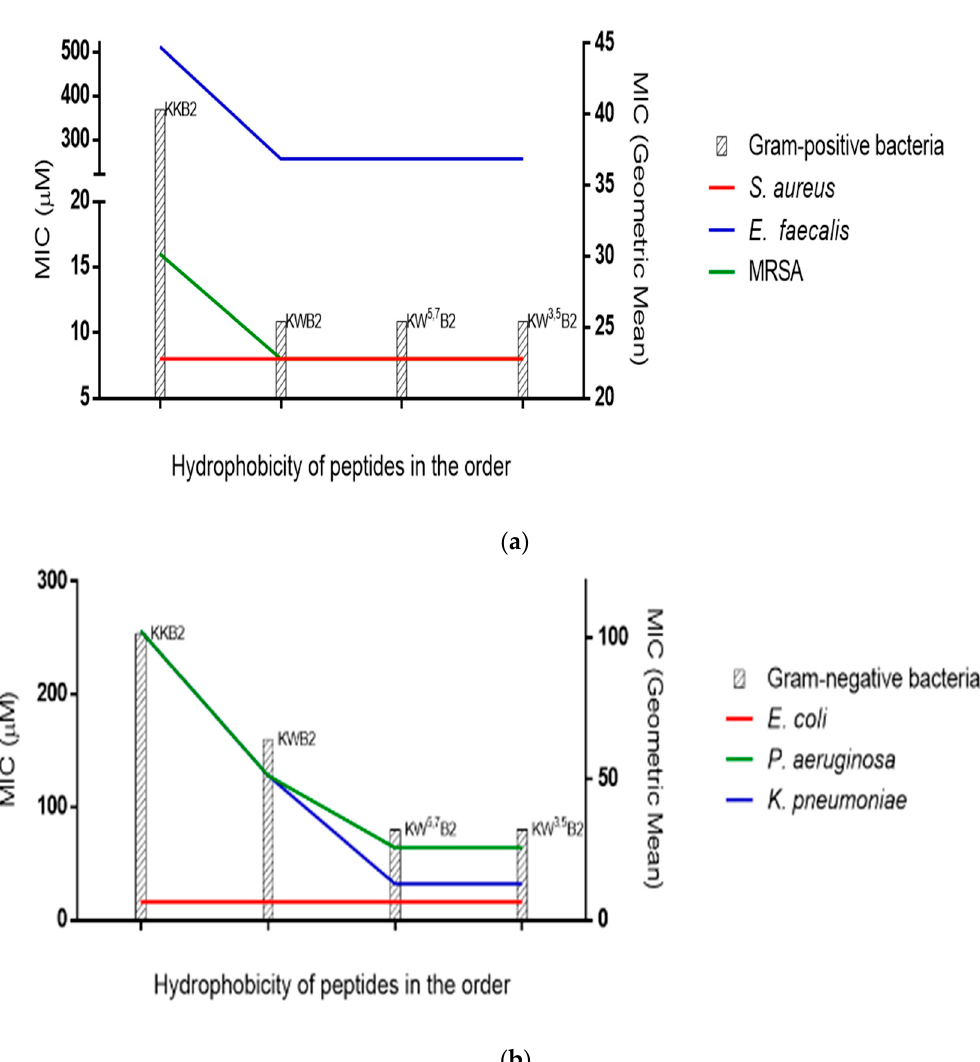
Figure 4 indicated a threshold of antimicrobial activity. Among those analogues, KWB2 (Figure 4a) corresponded most closely to the hydrophobic threshold against Gram-positive bacteria, and KW 5,7 B2 (Figure 4b) was closest against Gram-negative bacteria.